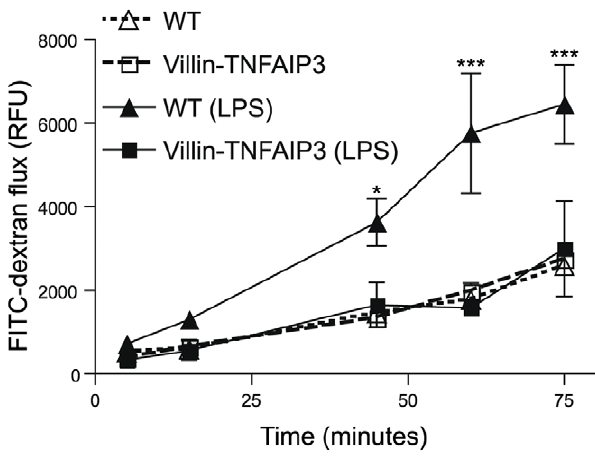
Figure 3. Intestinal epithelial cell-specific expression of TNFAIP3 protects against LPS-induced loss of barrier function. Explanted intestinal loops from WT (triangles) or villin-TNFAIP3 transgenic mice (squares) were assayed for barrier function beginning 45 minutes after injection of LPS (0.1 mg/mouse, , 5 mg/kg i.p.; filled symbols) or in untreated animals (open symbols). The flux of FITC- dextran over time out of the loops was measured in relative fluorescent units (RFU) per cm of intestinal tissue. Increased FITC-dextran flux indicates decreased barrier function. (*p , 0.05, ***p , 0.001; WT untreated vs. WT LPS treated).